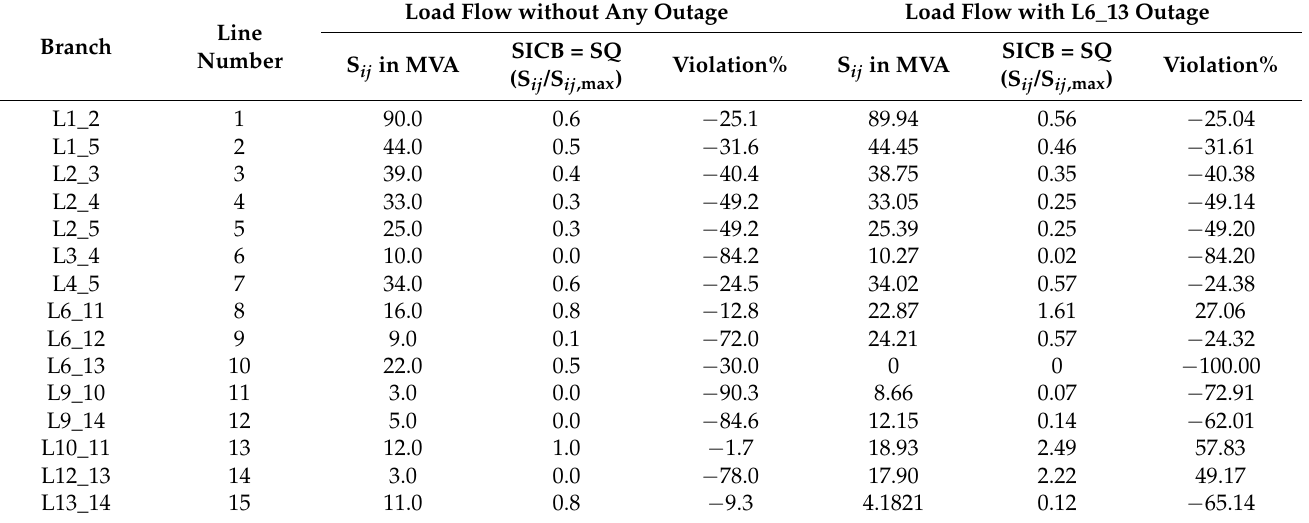
Table 2. Number of congested lines and severity index (SI) for various outage cases in the modified IEEE 14-bus system.